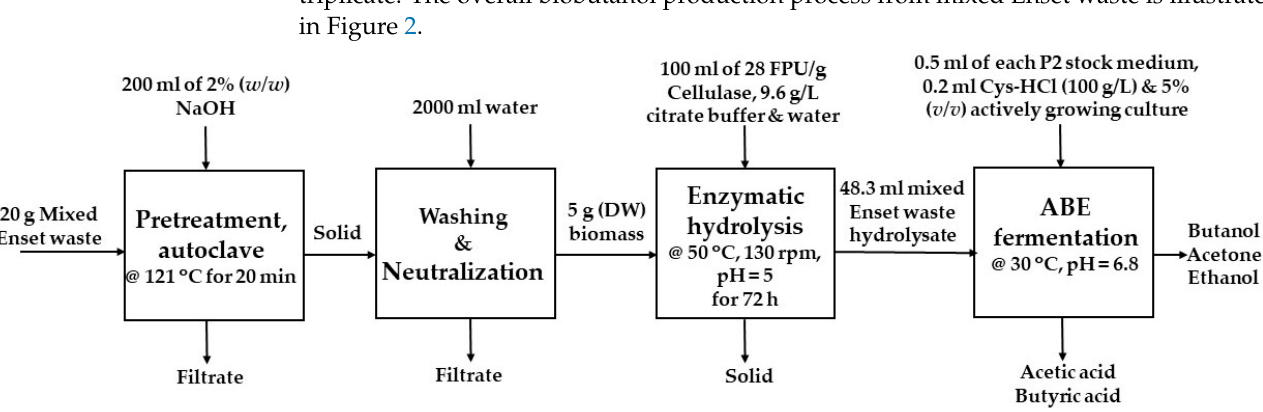
Figure 2. Biobutanol production process from mixed Enset waste.